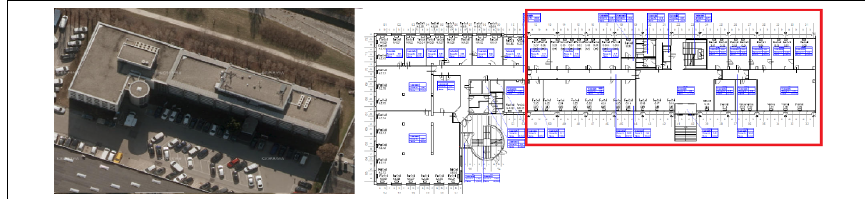
Figure 1: Aerial view of the building (left, ViennaGIS [9]) and a typical (cid:13)oor plan (right, Caverion (cid:127)Osterreich GmbH)